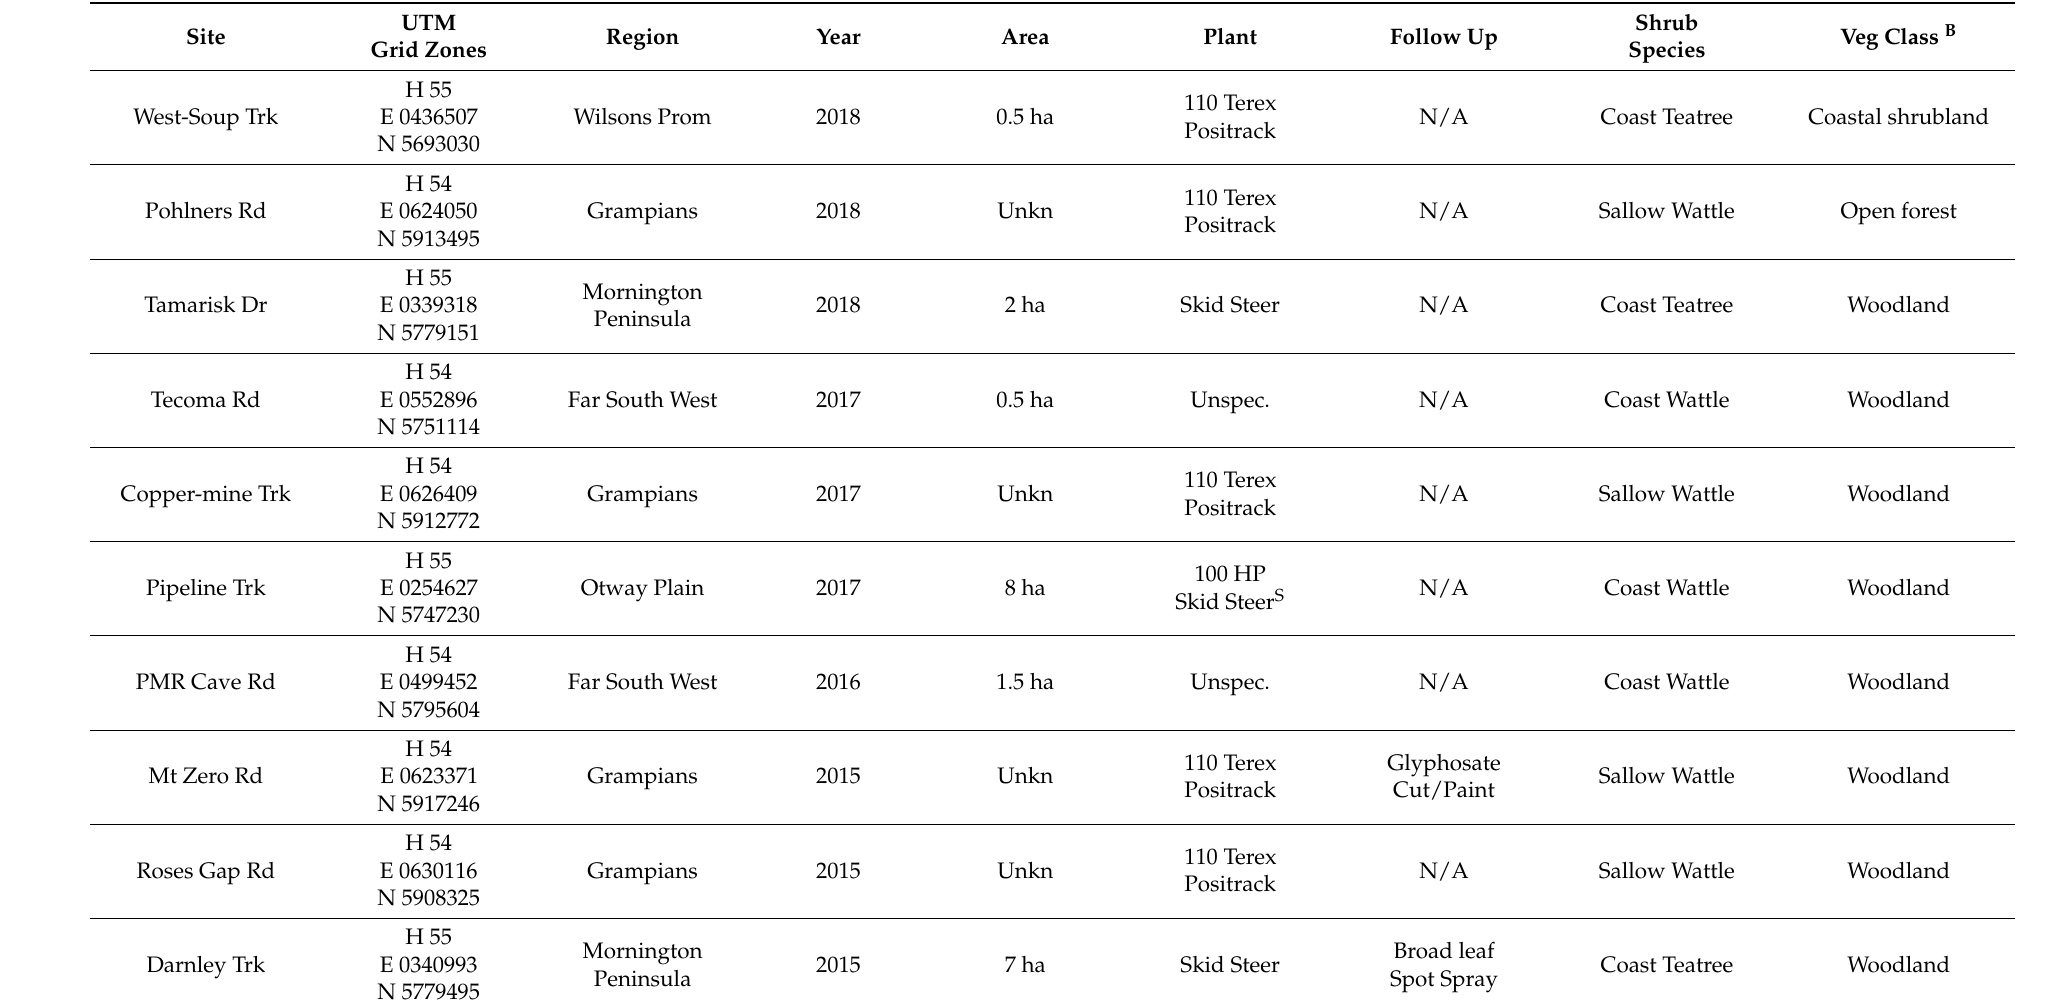
Table 1. Details about the masticated